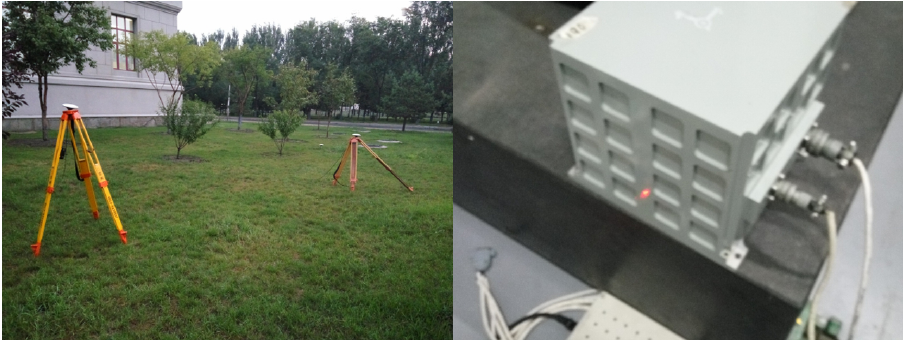
Figure 3. The arrangement of a tightly coupled INS/GNSS integrated navigation system for static testing.